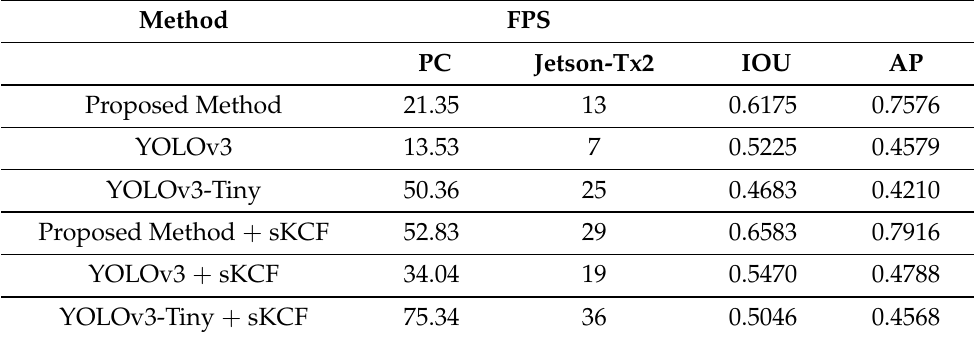
Table 4. Quantitative results for 10,000 testing video frames. The algorithms are tested on both PC and a Jetson TX2 GPU embedded system mounted onto